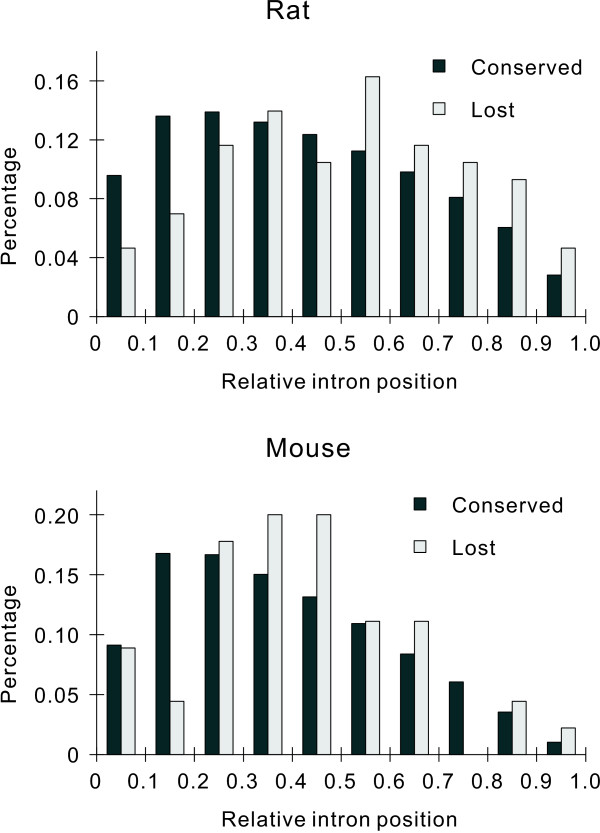
Relative positions of lost and conserved introns to the 5' end of genes. In rats, lost introns (n = 86) are located closer to the 3' end of genes than conserved introns (n = 148,176) (Mann-Whitney U test, P = 0.001). In mice, the difference is not significant (45 lost introns versus 148,176 conserved introns, P = 0.162).